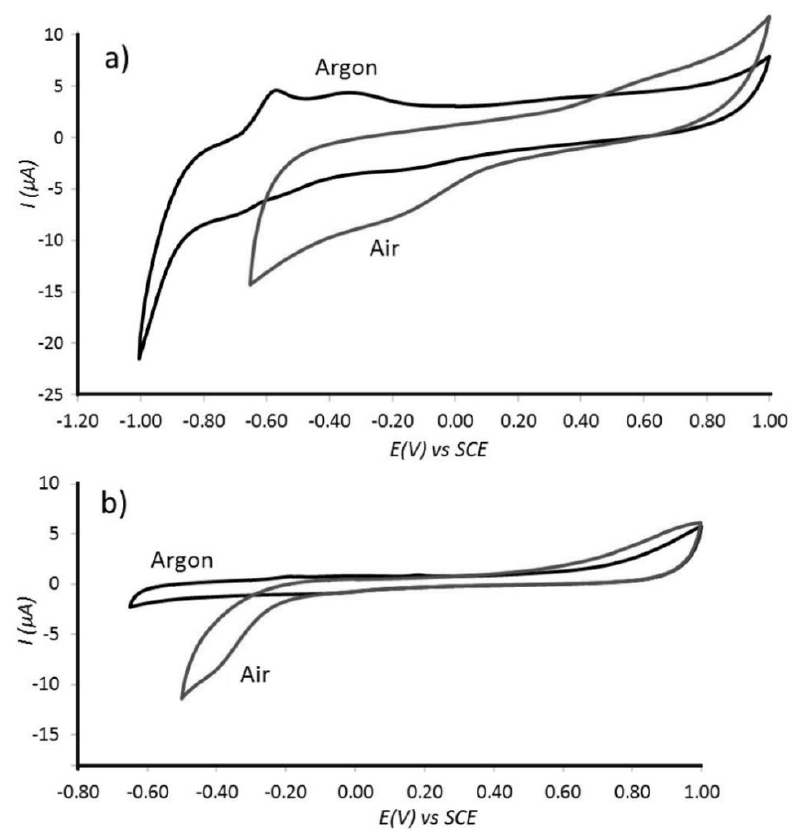
Figure 7. Cyclic voltammogram (3rd cycle, scan rate ( a ) 10 mV s −1 and ( b ) 5 mV s −1 ) for oxygen reduction at Pt@cPIM immobilized onto a 3 mm diameter glassy carbon electrode immersed into 10 mM phosphate buffer solution pH 7 purged with either Ar or air.